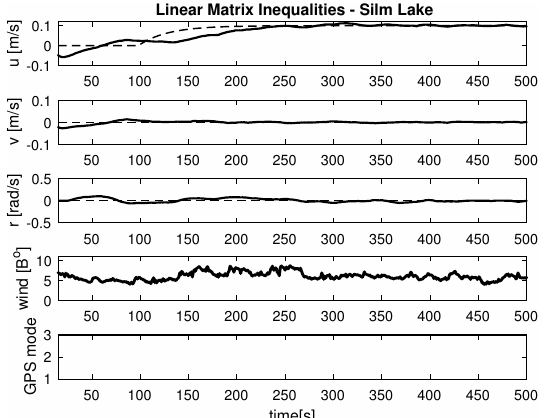
Figure 9. Ahead maneuver with longitudinal velocity u = 0.1 [m/s], v = 0 [m/s], r = 0 [rad/s], wind [ B o ] and GPS mode [-], maneuver duration 500 [s].